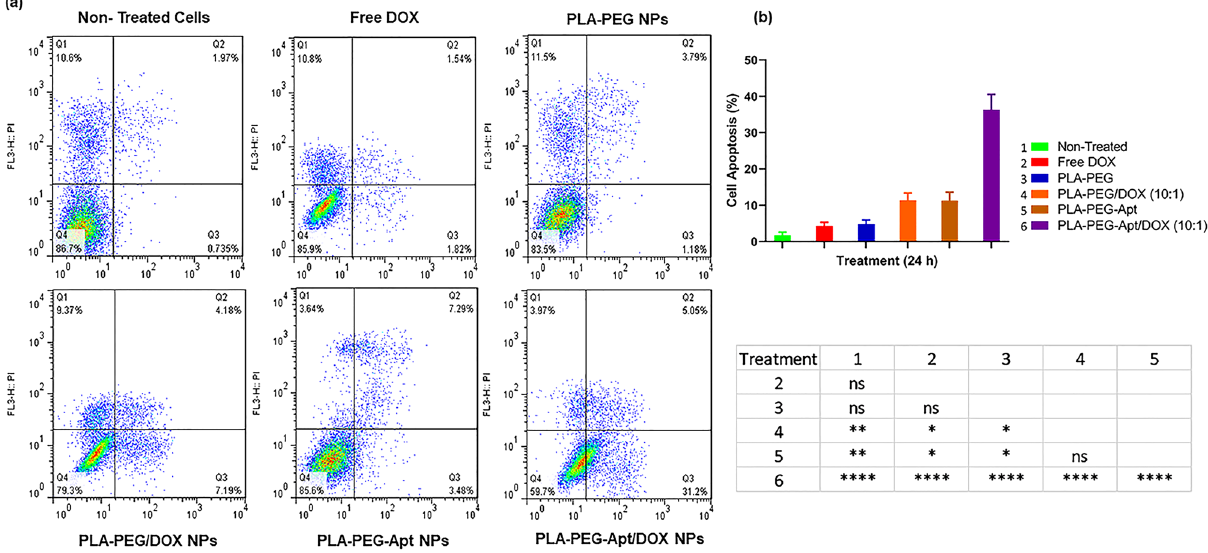
Figure 7. Cellular apoptosis. ( a ) Flow cytometry histograms of A-549 cells treated with Free DOX, PLA-PEG NPs, PLA-PEG/DOX NPs, PLA-PEG-Apt NPs, and PLA-PEG-Apt/DOX NPs for 24 h using Annexin V-FITC/ PI staining (Q1: dead cells with Annexin V-FITC (−)/PI (+), Q2: late apoptotic cells with Annexin V-FITC (+)/ PI (+) Q3: live cells with AnnexinV-FITC (−)/PI (−), Q4: early apoptotic cells with Annexin V-FITC (+)/PI (−)). ( b ) The number of apoptosis cells was counted with a FACS Calibur flow cytometer for A-549 cells (P-value: ns is not-significance (≥ 0.05). * is significant between 0.01 and 0.05., ** is significant between 0.001 and 0.01., and ****, significant <